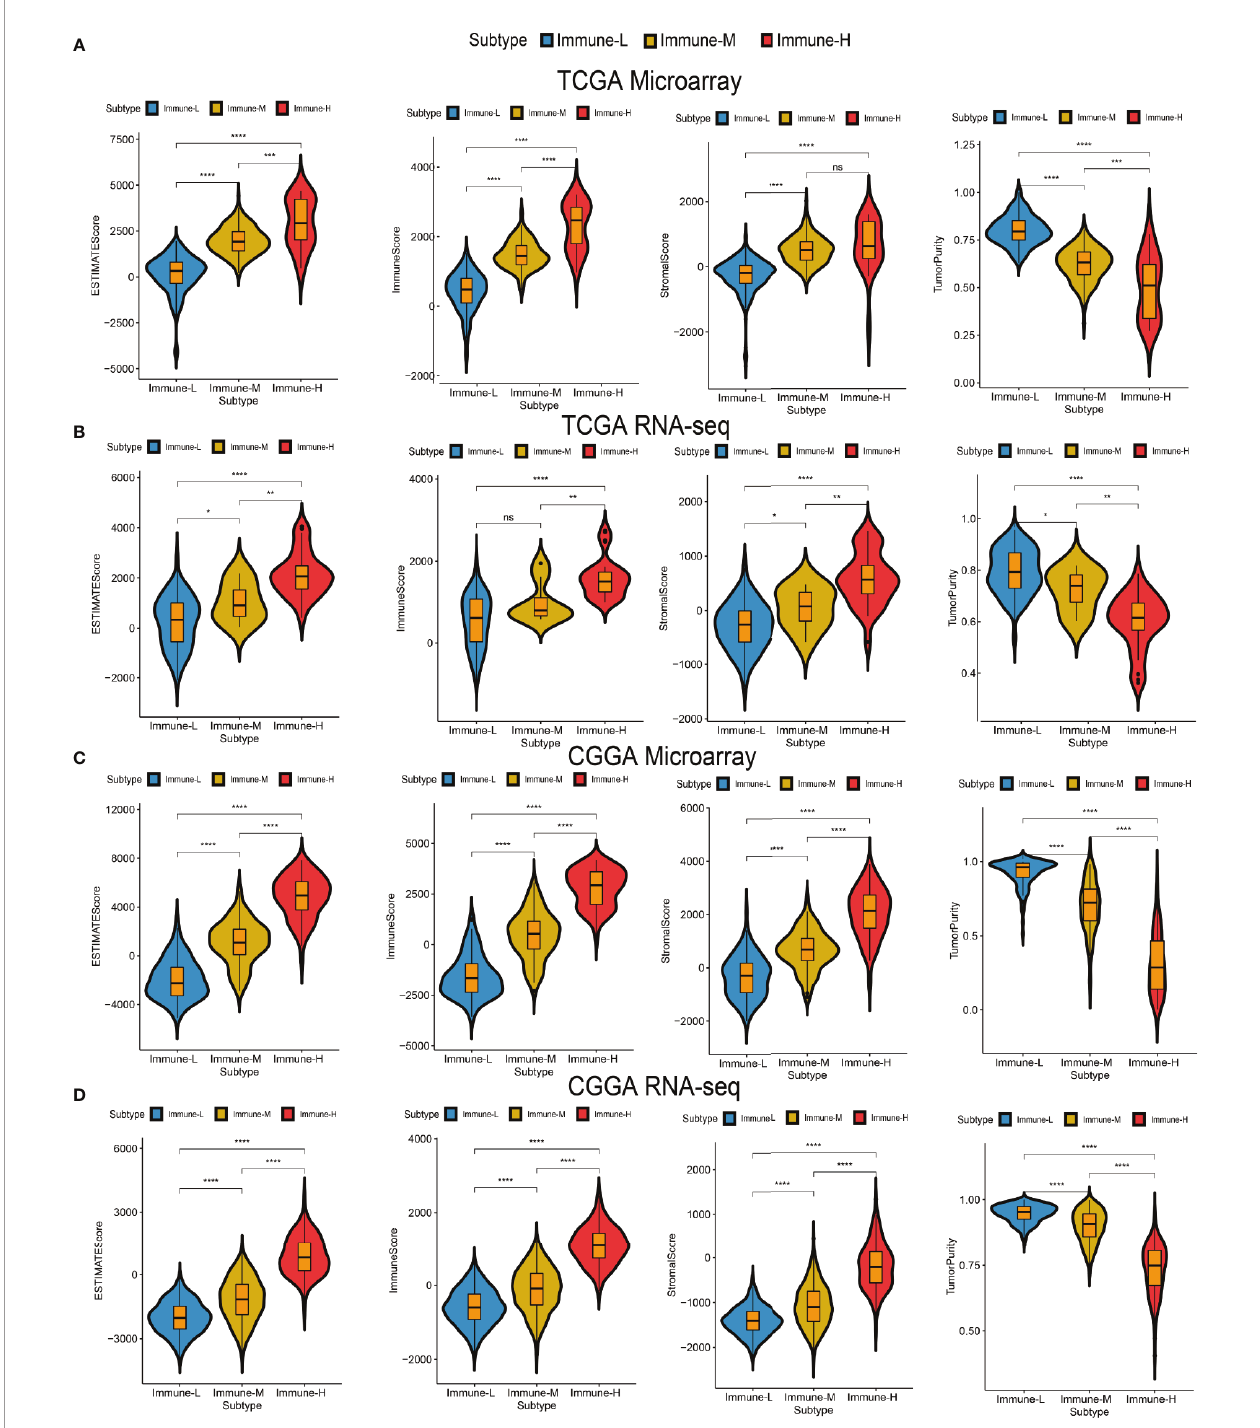
FIGURE 2 | Differences among immune phenotypes in terms of four glioma immune microenvironment signatures. (A – D) Violin plots comparing the ESTIMATE, immune and stromal scores and tumor purity among immune phenotypes in the TCGA microarray, TCGA GBM RNA-seq, CGGA microarray, and CGGA RNA-seq cohorts respectively. P values for Wilcoxon test were shown on the top of each violin plot. *P < 0.05; **P < 0.01; ***P < 0.001; ****P < 0.0001. ns, not signi fi